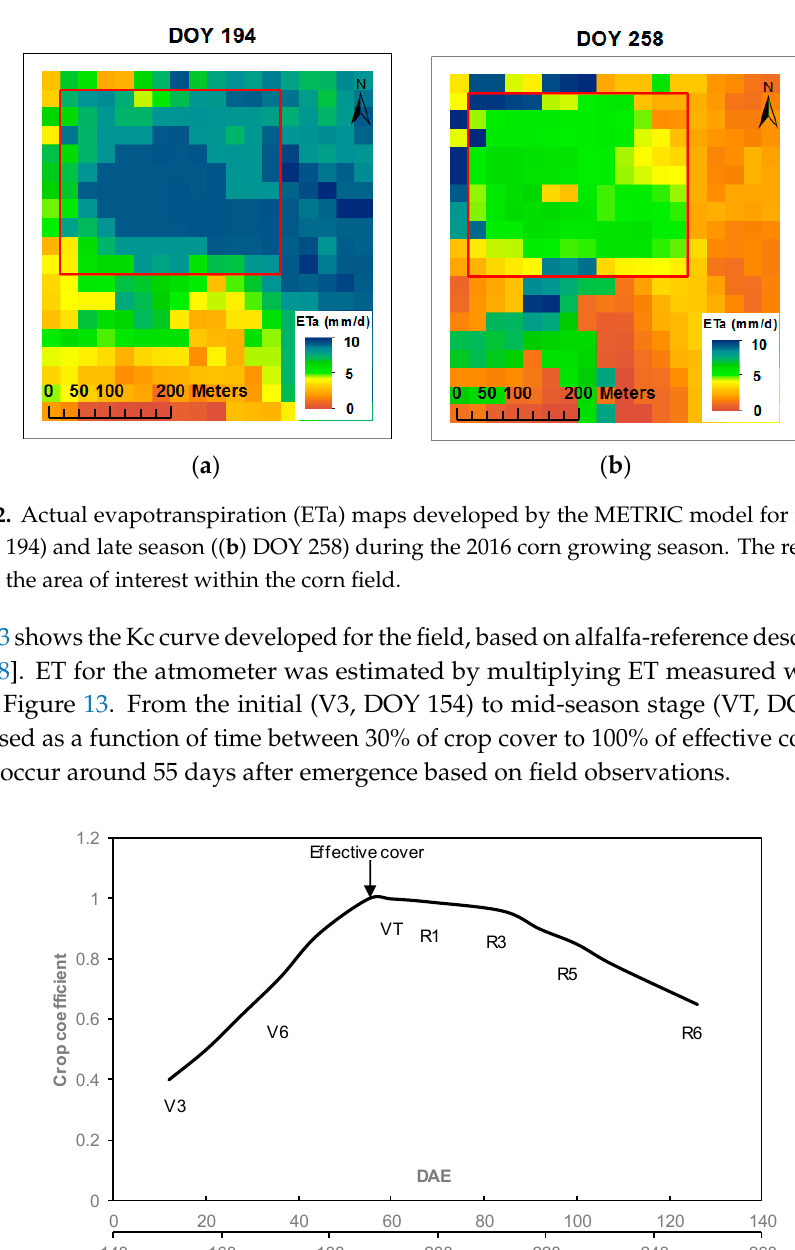
Figure 12. Actual evapotranspiration (ETa) maps developed by the METRIC model for mid- season (DOY 194) and late season (DOY 258) during the 2016 corn growing season. The red rectangle indicates the area of interest within the corn field. Table 5. ETa values estimated by the METRIC model for five observation locations and six overpass dates during season.